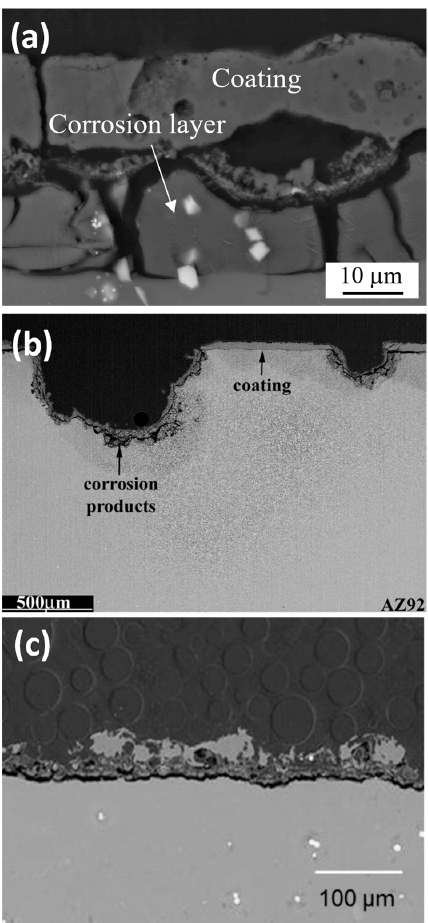
Figure 11. SEM microphotographs showing the types of corrosion morphologies of PEO-coated Mg alloys: ( a ) general undercoating corrosion [49,117], ( b ) localized corrosion [118], and ( c ) coating dissolution [116]. Reprinted ( a ) from [49], ( b ) from [118], ( c ) from [116] with permission from